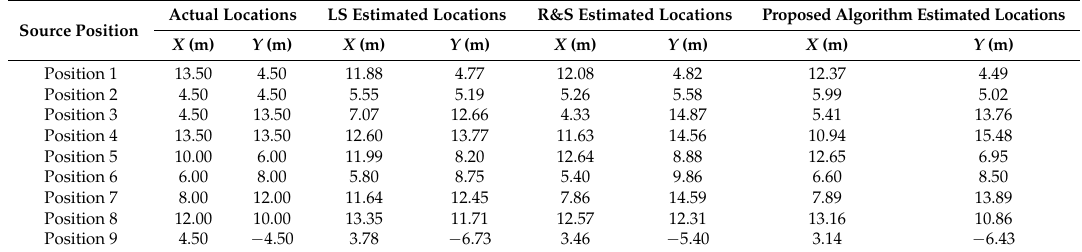
Table 5. Comparison of estimated versus true location with seven measurement sensors.